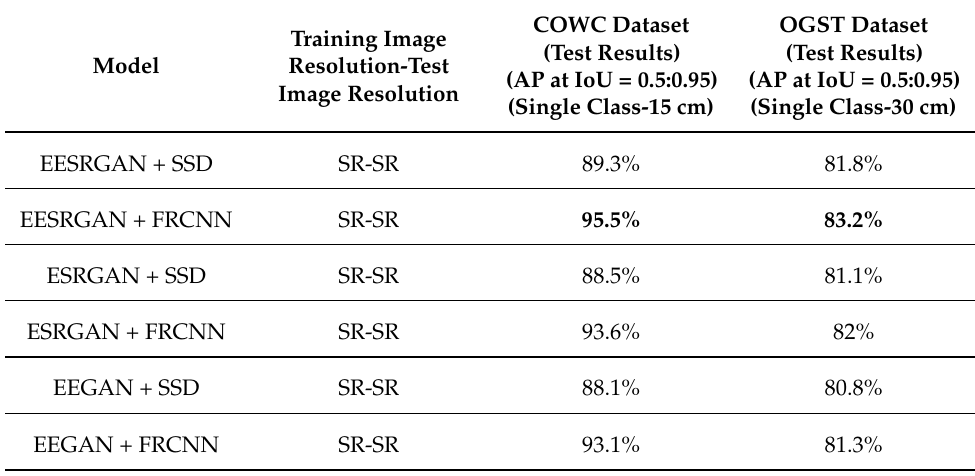
Table 3. Detection with end-to-end SR (super-resolution) network. Detectors are trained with SR images and AP (average precision) values are calculated using 10 different IoUs (intersection over